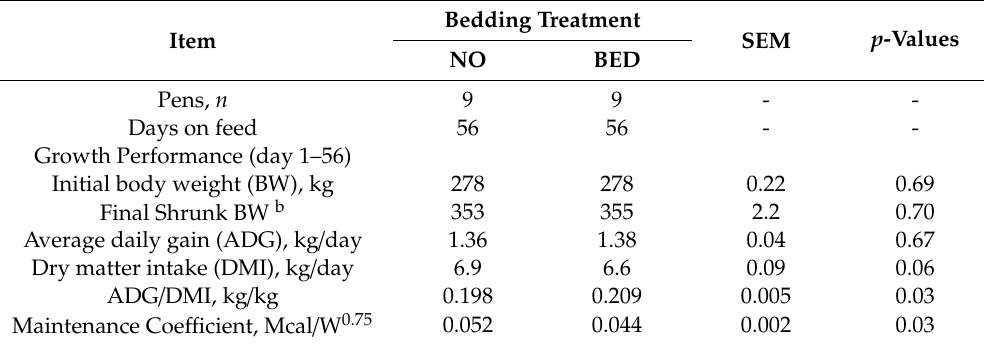
Table 4. Experiment 2: Effect of bedding on cattle growth performance a .